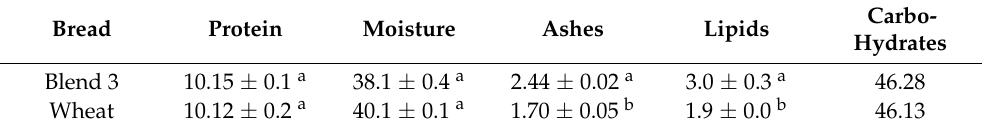
Table 6. Proximate composition of the breads prepared with blend 3 and with 100% wheat.